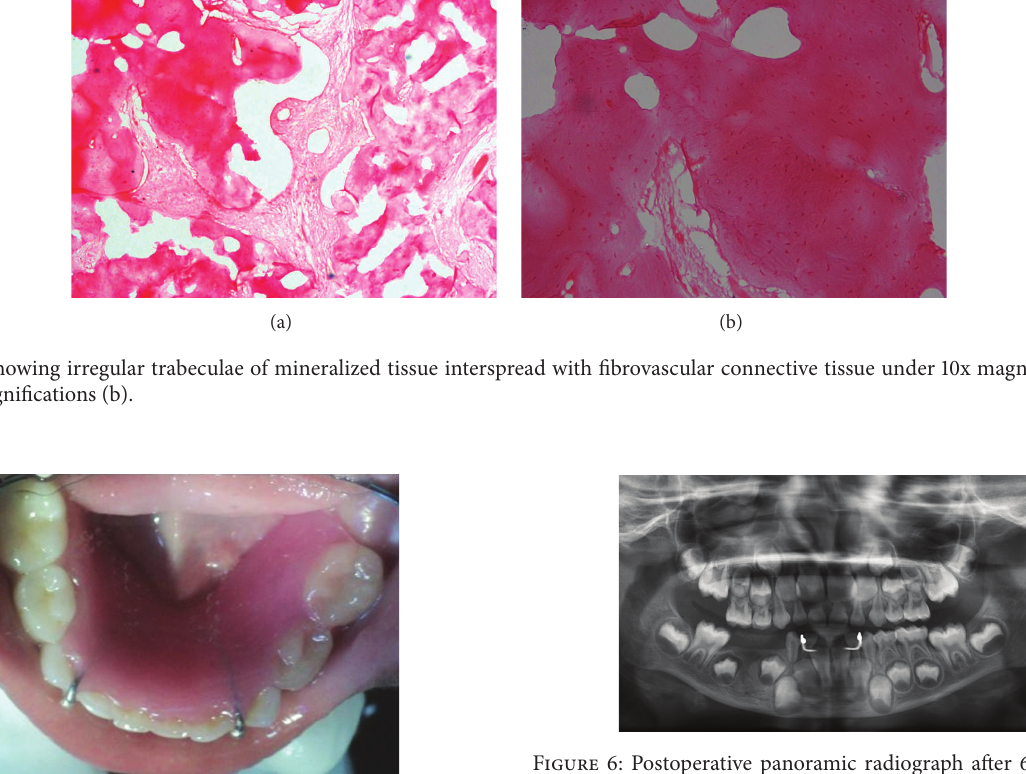
Figure 6: Postoperative panoramic radiograph after 6 months of follow-up with a space maintainer and no evidence of